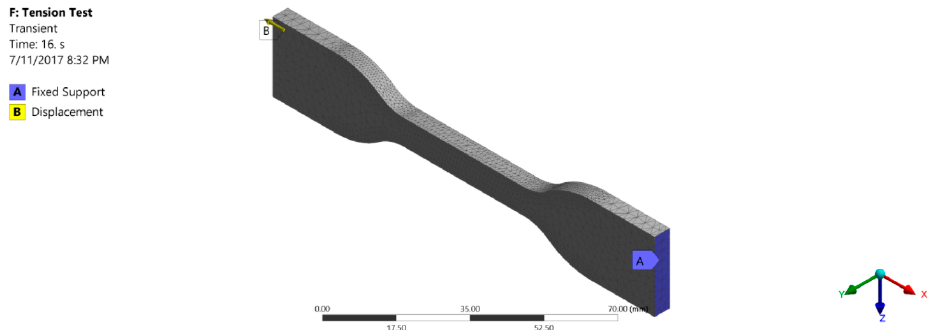
Figure 2. Isometric view of model showing constraints used for tension test simulation.